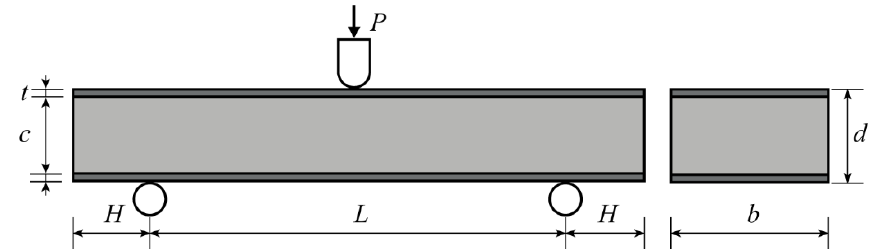
Figure 3. Sketch of AFS subjected to the three-point bending test.